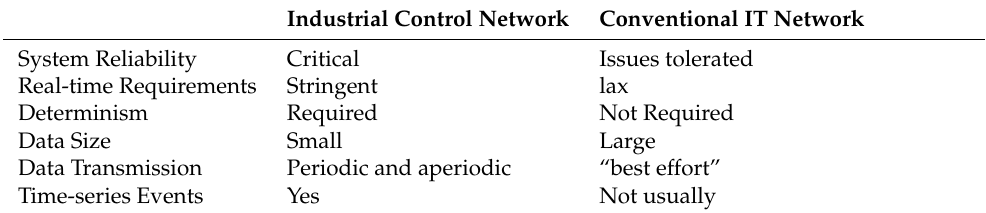
Table 2. Industrial control network vs. conventional IT